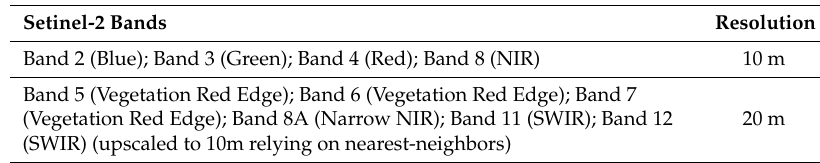
10. Figure 10. Schematic flow diagram of the supervised approach. Table 2. Details on the S2 bands used.